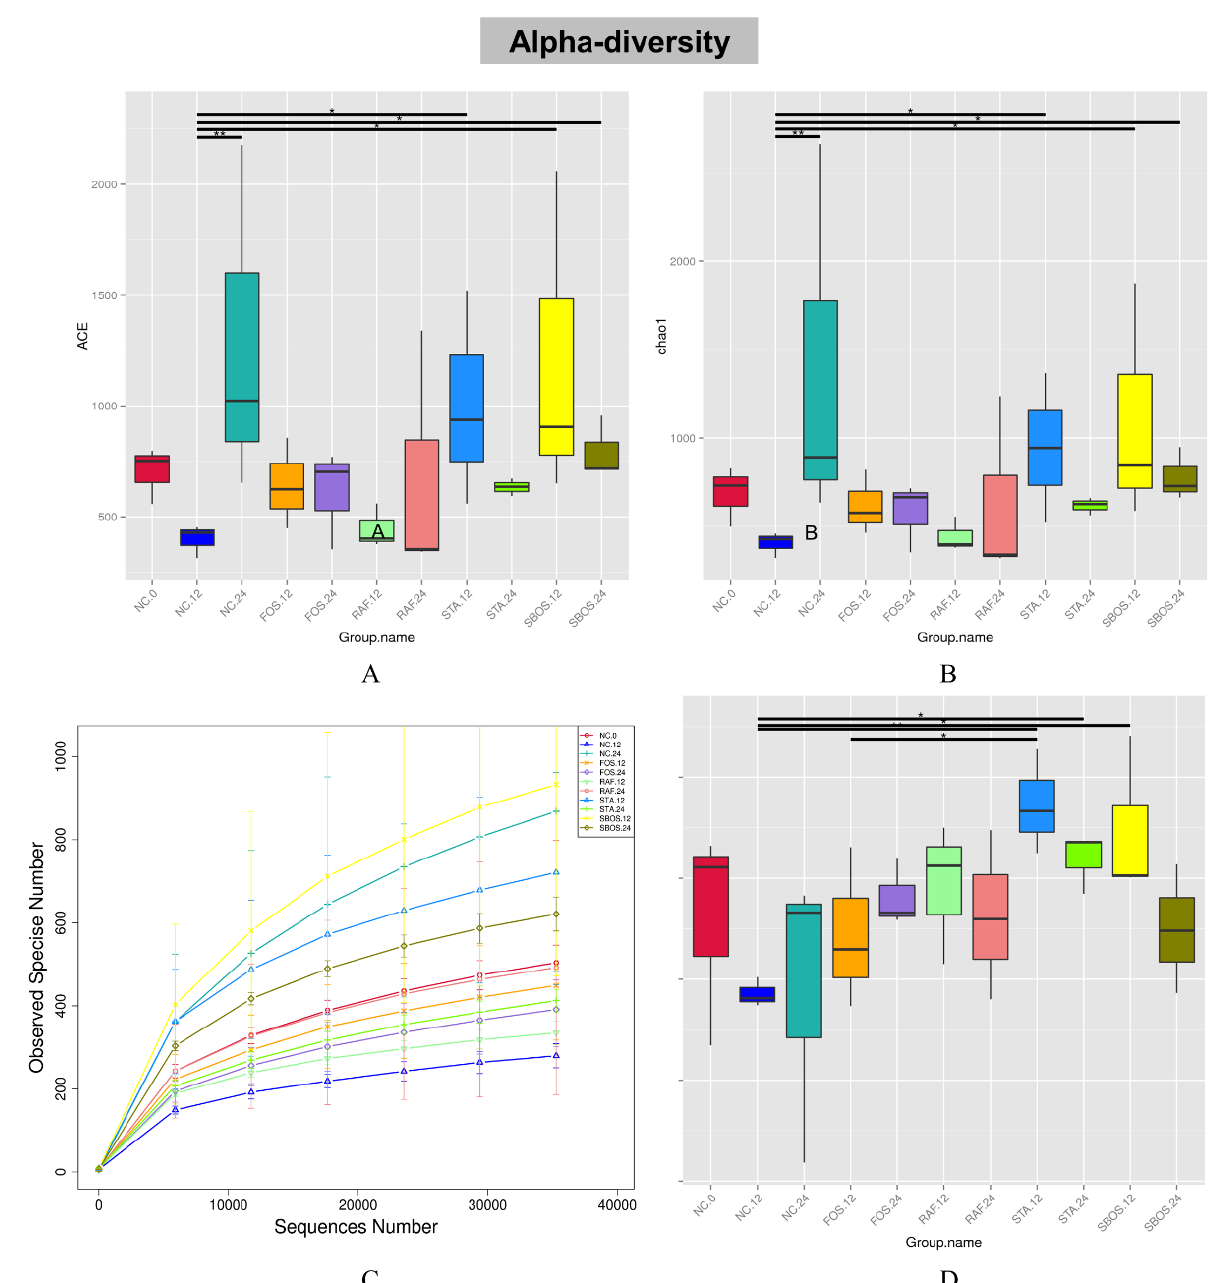
Figure 5. Alpha diversity including ACE ( A ), Chao 1 ( B ), rarefaction curves ( C ), and Shannon index ( D ).